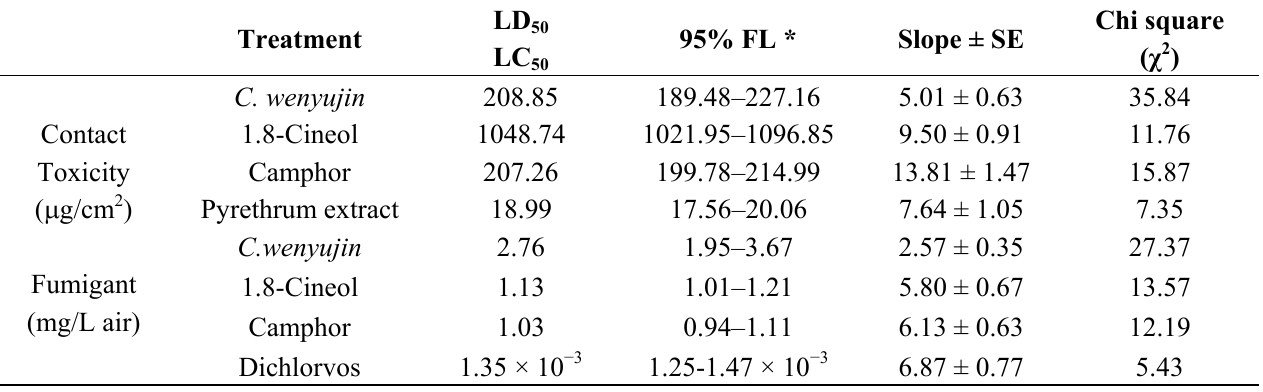
Table 2. Contact toxicity and fumigant toxicity of the essential oil of Curcuma wenyujin rhizomes and its constituents against Liposcelis bostrychophila .